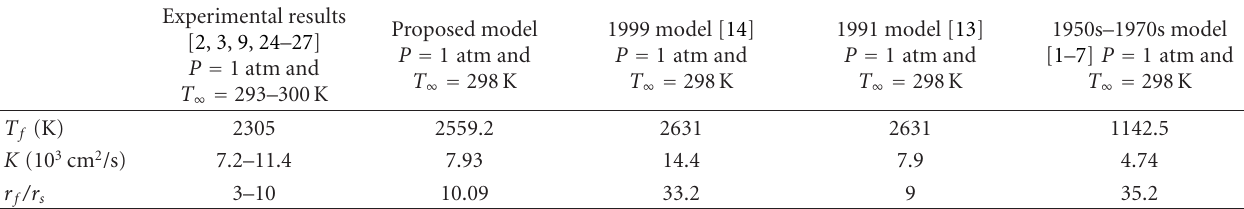
Table 4: Proposed model n -heptane results compared with published experimental observations. Experimental